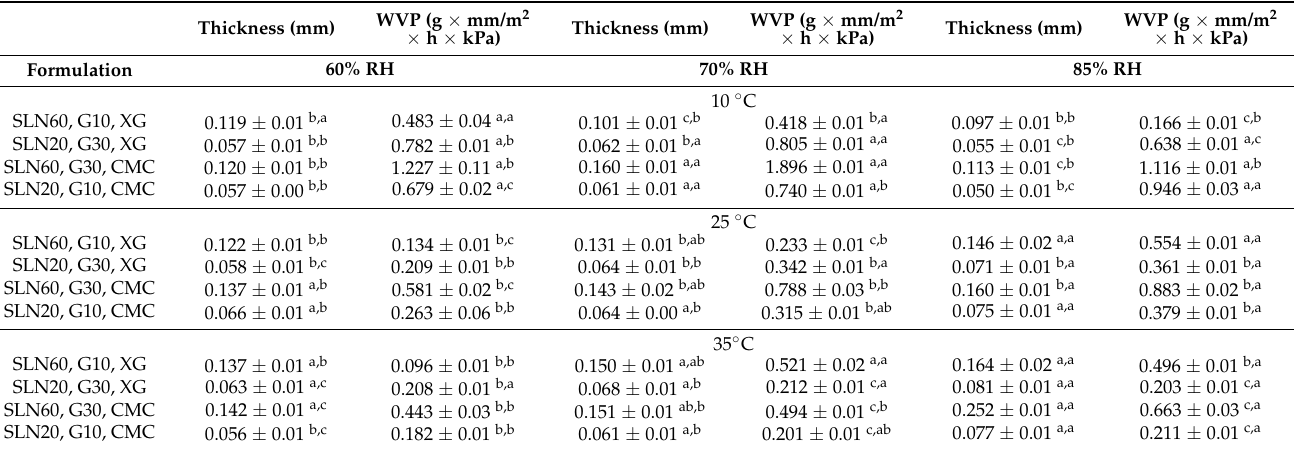
Table 3. Thicknesses and WVP of edible films under different storage